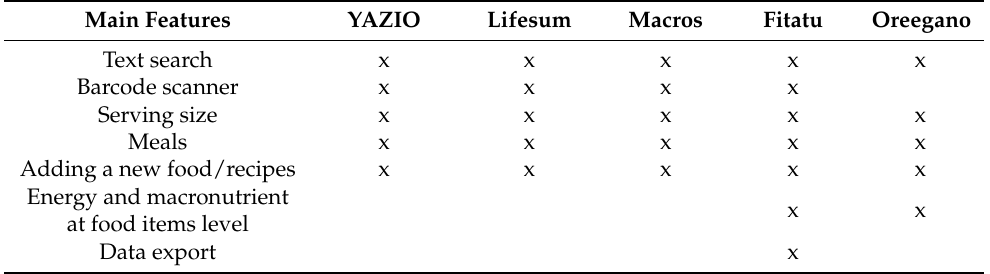
Table 2. Main features of the